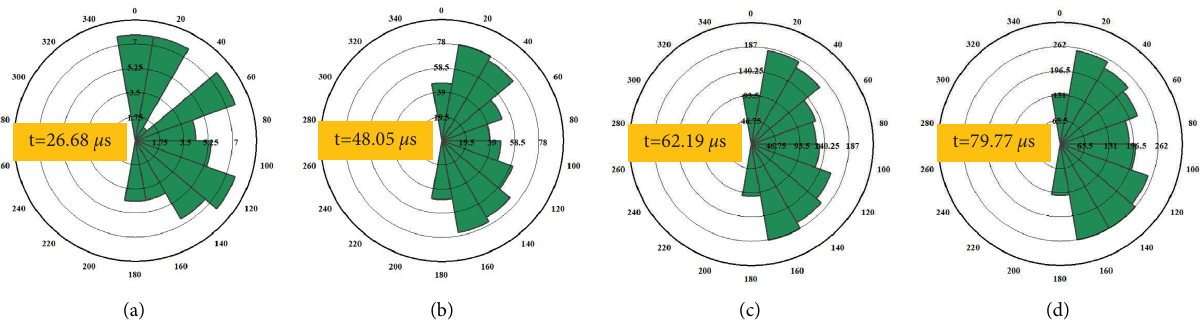
Figure 7: Te process of evolution of crack anisotropy during the numerical compression test on the sand specimen. (a) t � 26.68 μ s, (b) t � 48.05 μ s, (c) t � 62.19 μ s, and (d) t � 79.77 μ